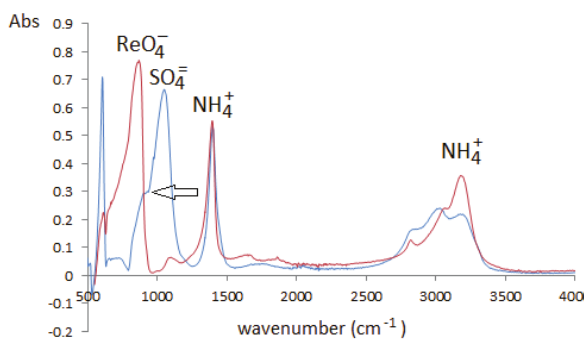
Figure 6: Two powder samples obtained from the purification process. Blue line: ReO 4– (8.5%) and SO 4= (71.3%) and red line: ReO 4– (92.4%) and SO 4=